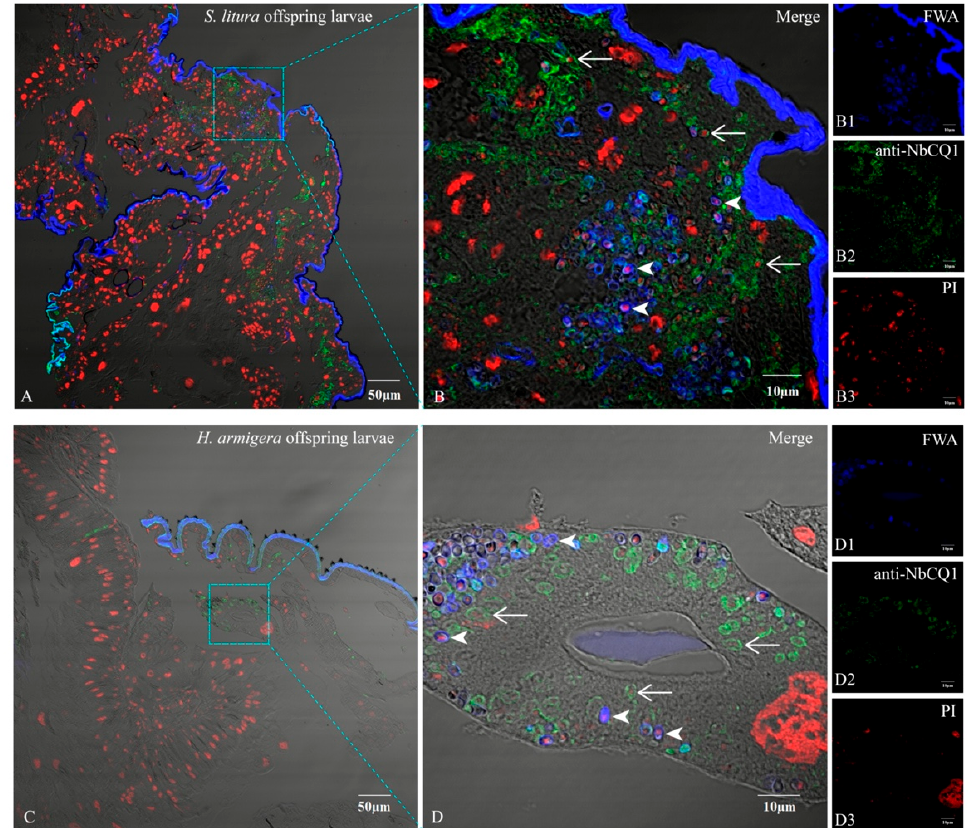
Figure 8. Paraffin section of the offspring larvae tissue of S. litura and H. armigera . ( A ) The tissues of S. litura offspring larvae infected by NbCQ1; ( B ) An enlarged view of NbCQ1 infections in S. litura offspring larva; ( B1 ) NbCQ1 spores stained with FWA; ( B2 ) Proliferative NbCQ1 labeled with antibody; ( B3 ) Nucleus stained by PI. ( C ) The tissues of H. armigera offspring larvae infected by NbCQ1; ( D ) An enlarged view of NbCQ1 infections in H. armigera offspring larva; ( D1 ) NbCQ1 spores stained with FWA; ( D2 ) Proliferative NbCQ1 labeled with antibody; ( D3 ) Nucleus stained by PI. The arrowhead shows the NbCQ1 spores, and the arrow shows pathogens in